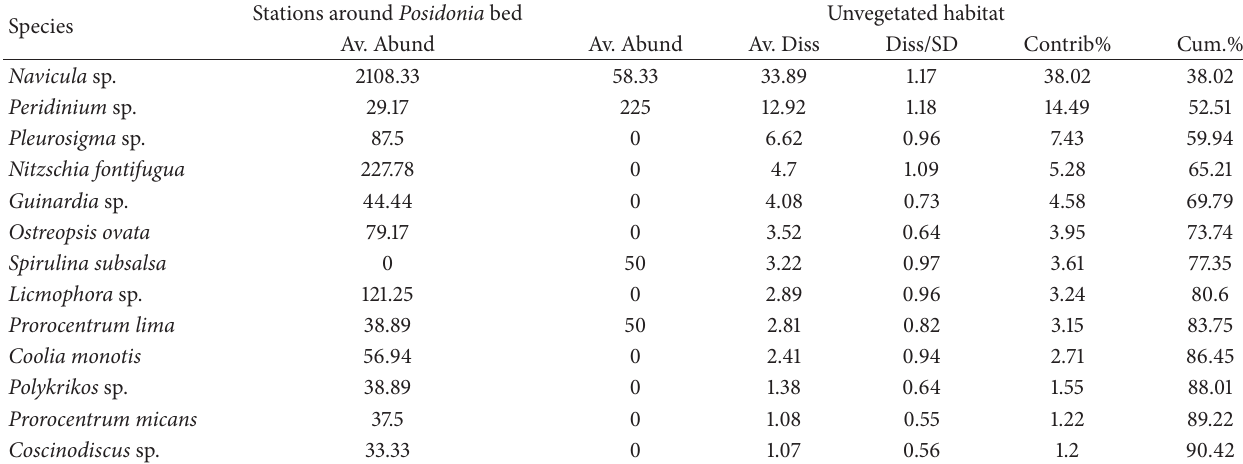
Table3:ResultsofSIMPERprocedureshowingdistributionofdiscriminatingspeciesbetweenstationsaround Posidonia bedandunvegetated